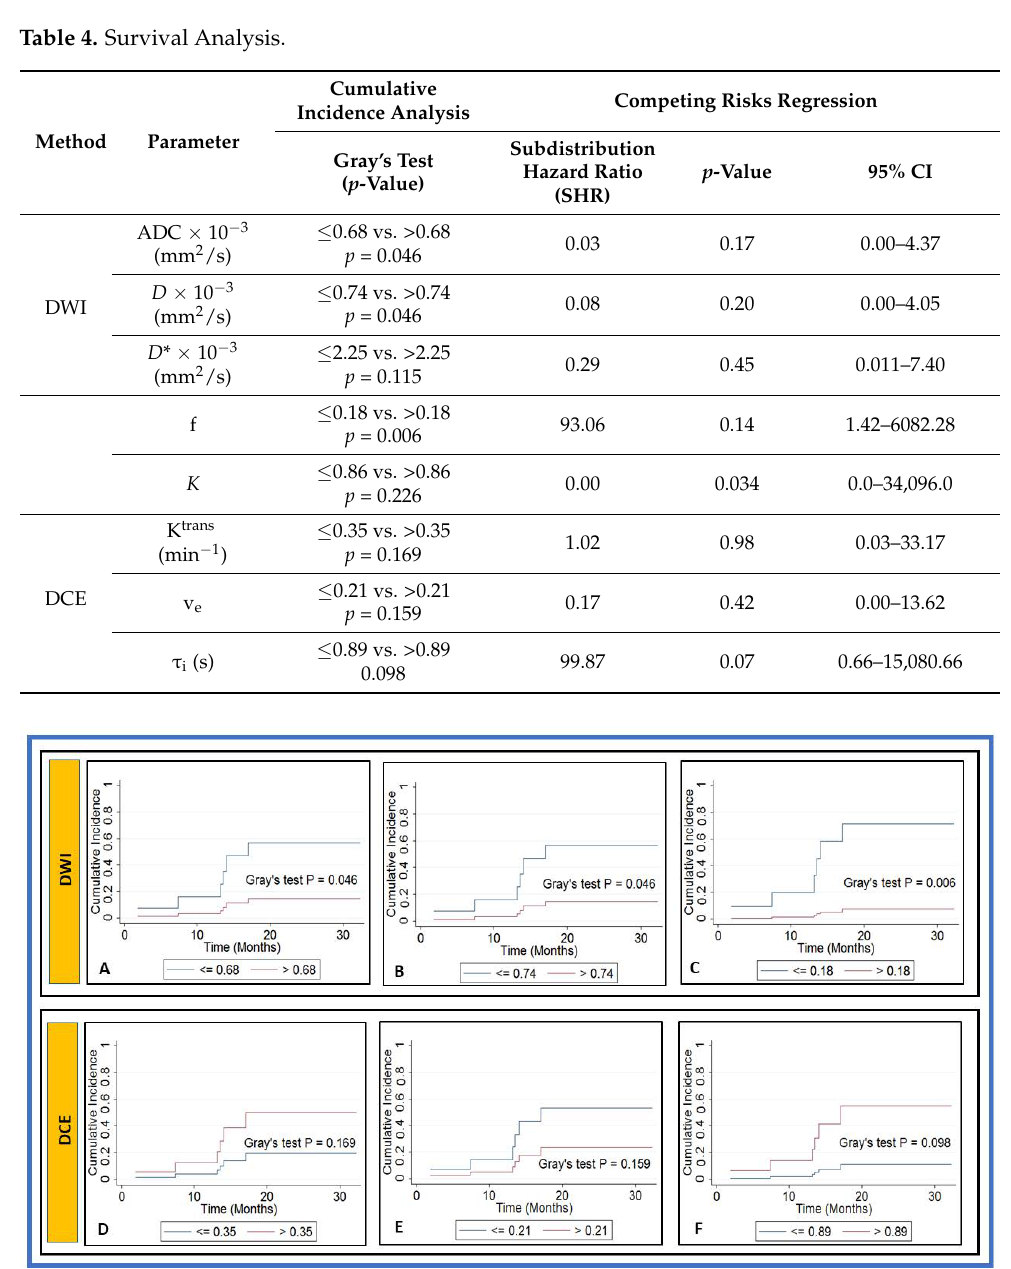
Figure 7. Cumulative incidence analysis based on locoregional failure (LRF) for pre-treatment ( A ) apparent diffusion coefficient (ADC [mm 2 /s]), ( B ) true diffusion coefficient ( D [mm 2 /s]), ( C ) perfu- sion fraction (f), ( D ) volume transfer constant (K trans [min − 1 ]), ( E ) volume fraction of extravascular extracellular space (v e ), and ( F ) mean lifetime of intracellular water protons ( τ i [s]). Gray’s test revealed a significant difference for ADC, D , and f ( p < 0.05), and borderline significance for τ i (s) ( p =